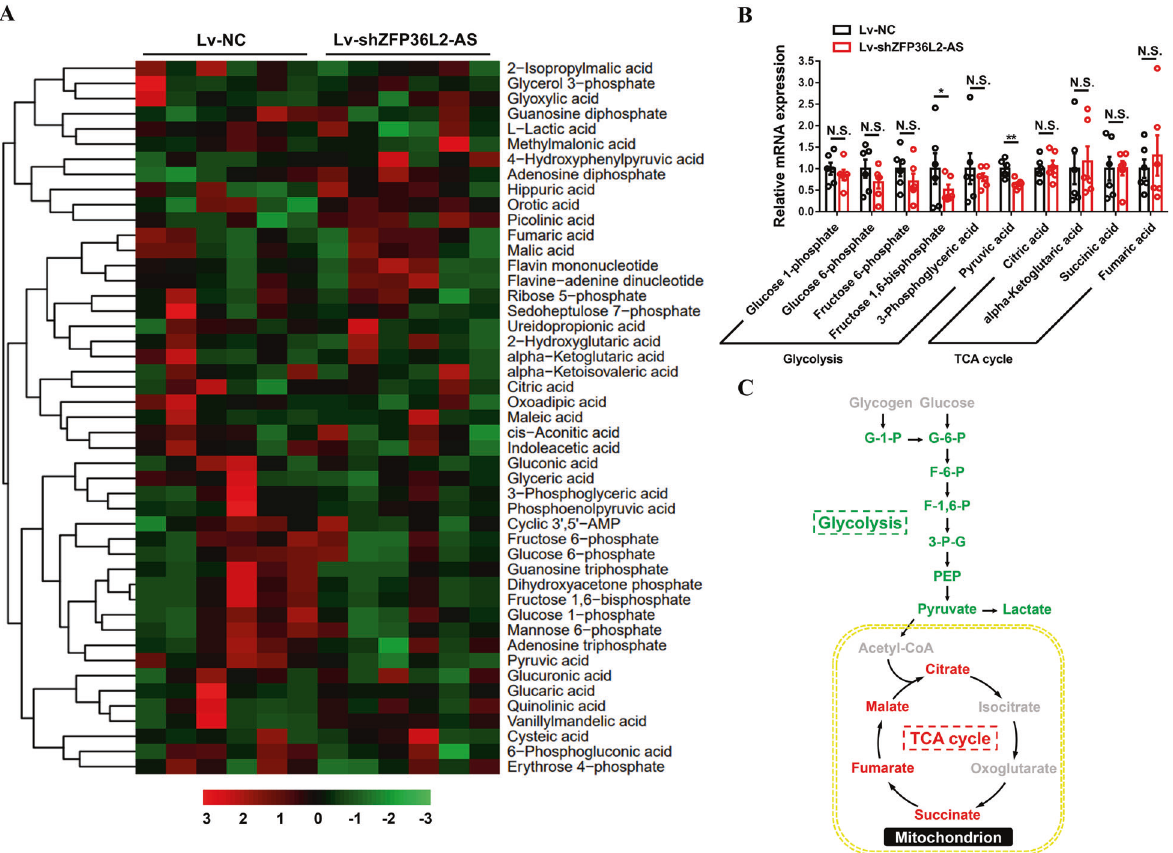
Fig. 4 Knockdown of lncRNA ZFP36L2-AS downregulates the TCA cycle. A Hierarchical clustering analysis (HCA) of metabolites in gastrocnemius after infected with Lv-shZFP36L2-AS or Lv-NC. The colors indicate the relative levels in lncRNA ZFP36L2-AS knockdown or control group. B Relative metabolite content of glycolysis and tricarboxylic acid (TCA) cycle in gastrocnemius with ZFP36L2-AS knockdown. C Schematic diagram of metabolic pathways of glycolysis and TCA cycle affected by ZFP36L2-AS knockdown in the gastrocnemius. Upregulated metabolites are shown in red, and the downregulated metabolites are shown in green. In panel ( C ), results are shown as mean ± SEM, statistical signi fi cance of differences between means was assessed using independent sample t -test. (* P < 0.05; ** P <